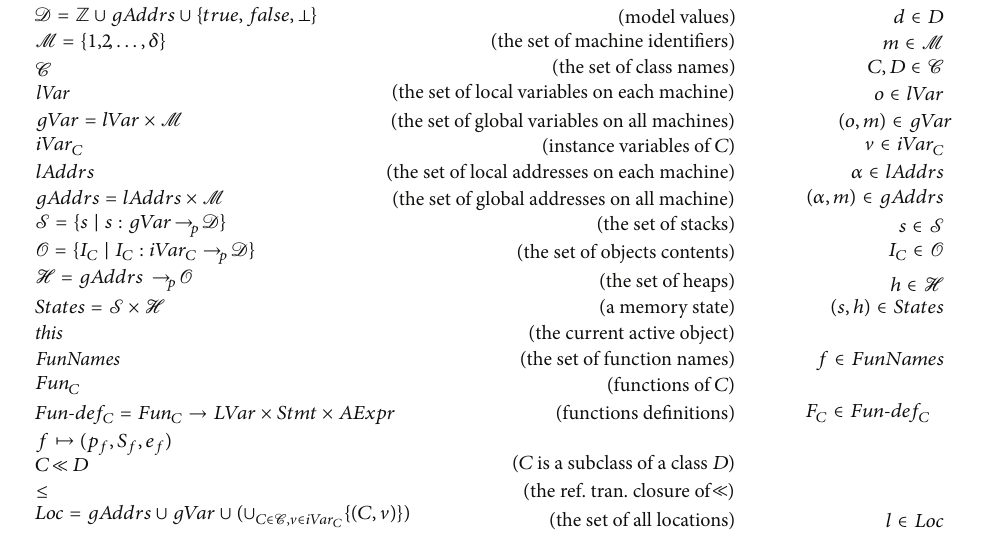
Figure 4: Semantic spaces and naming